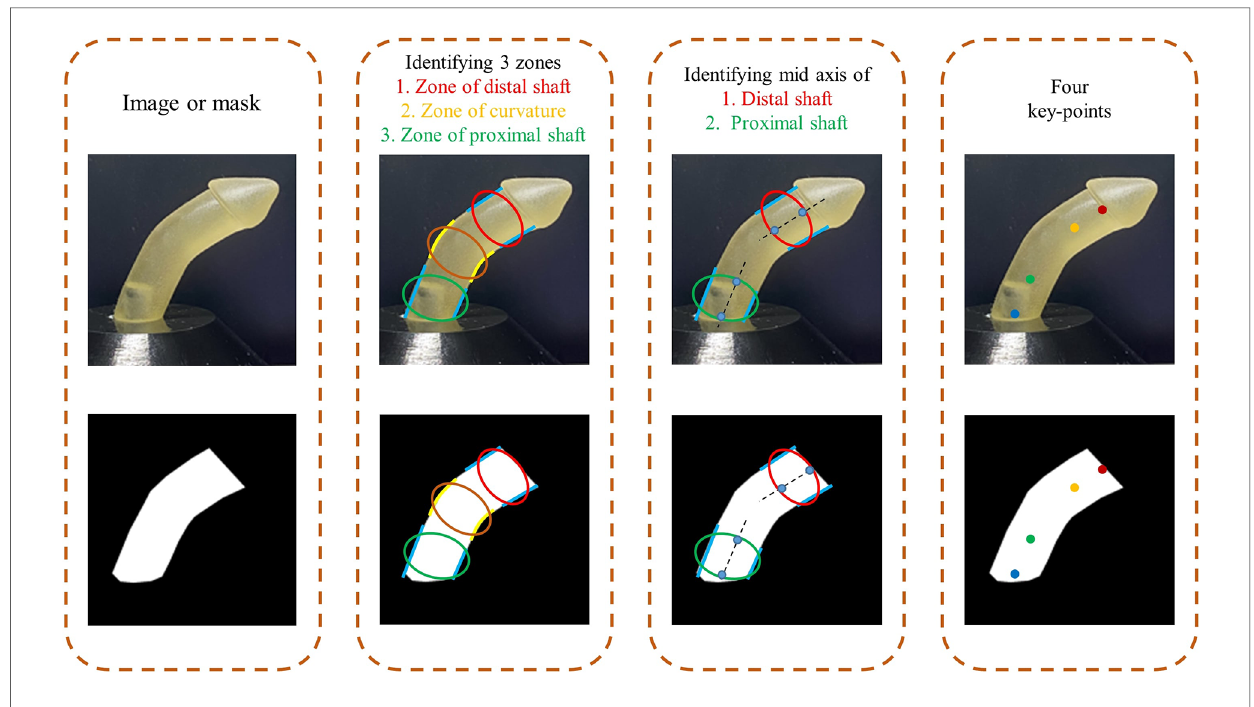
FIGURE 4 Identifying four key points of the penile shaft on cropped image and generated